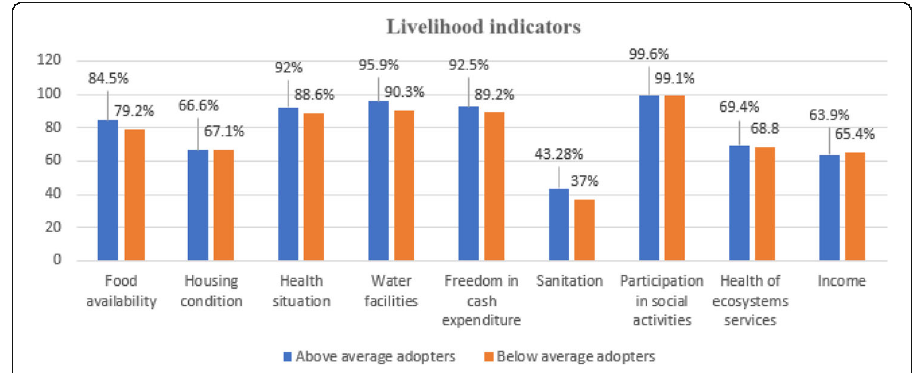
Fig. 3 A bar chart showing percentages of ALSS indicators. Source: Field survey,